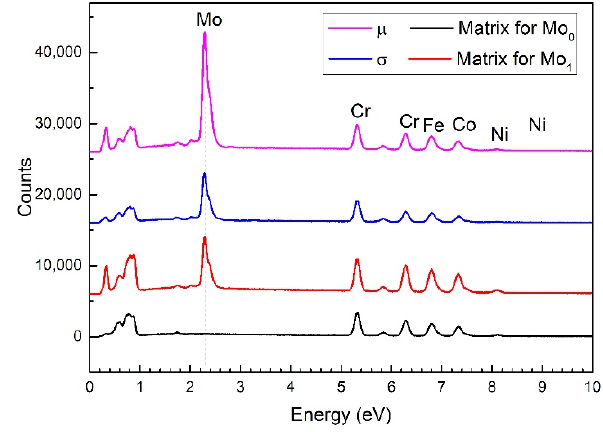
Figure 4. EDS analysis of the elements for different phases. Table 1. Chemical composition of the different phases in the studied compounds (normalized molar ratio).